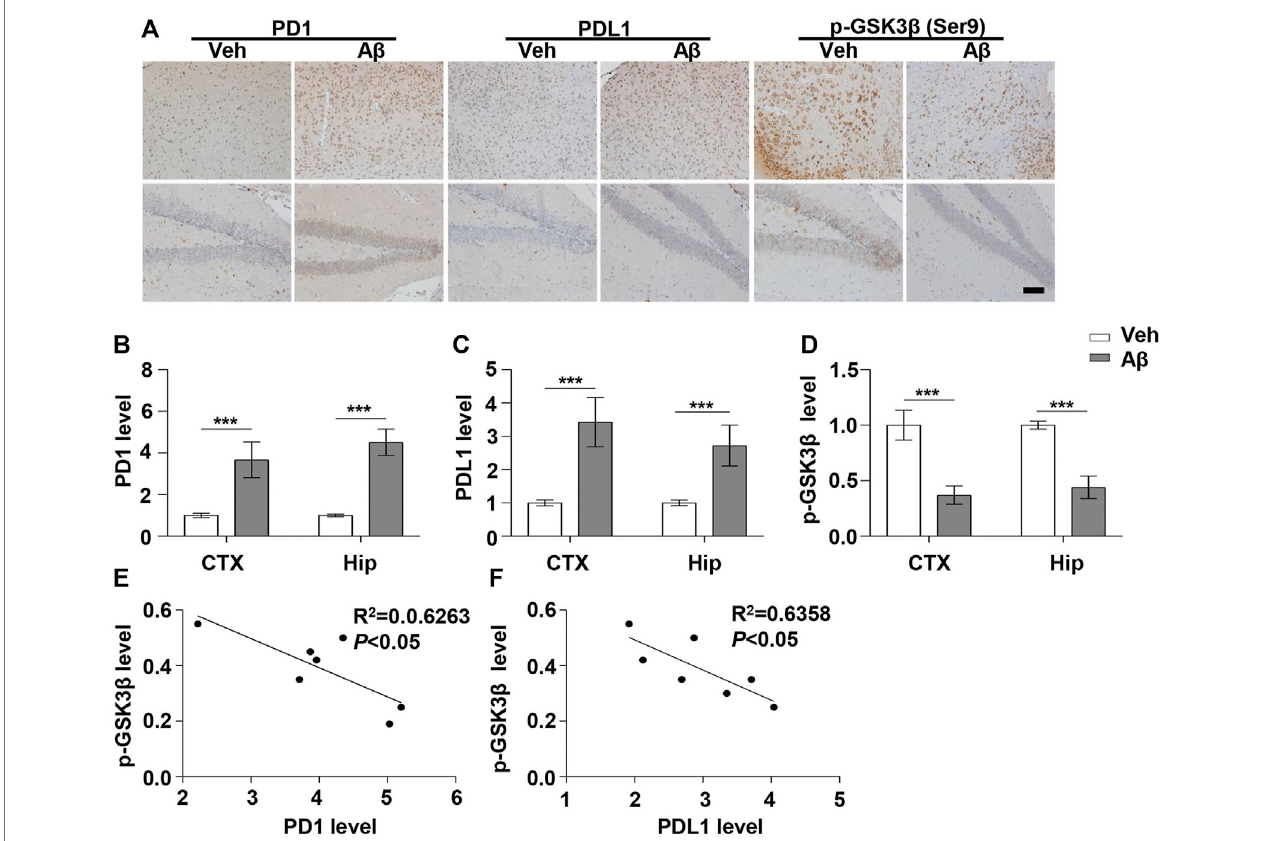
FIGURE1| PD1andPDL1levelswereelevated inthemousebrainpostA β 42insult. A β 42wasadministered toWT(C57BL/6, female/male,aged2 – 3 months,n (cid:2) 7/group) mice, and after 12 days, the brain tissues were harvested. (A – D) Immunohistochemistry analysis using the anti-PD1, anti-PDL1, and p-GSK3 β (Ser9) antibodies was performed with paraf fi n-embedded brain tissue sections from the vehicle and A β 42-treated mice. *** p < 0.001; paired t -test, scale bar (cid:2) 100 μ m. (E,F) Correlation between the hippocampal p-GSK3 β (Ser9) level on the Y -axis and the corresponding PD1 or PDL1 level on the X -axis (Pearson correlation coef fi cient, R 2 (cid:2) 0.6263, p < 0.05, or R 2 (cid:2) 0.6358, p < 0.05, respectively).